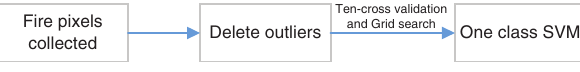
Figure 2: Training Process of